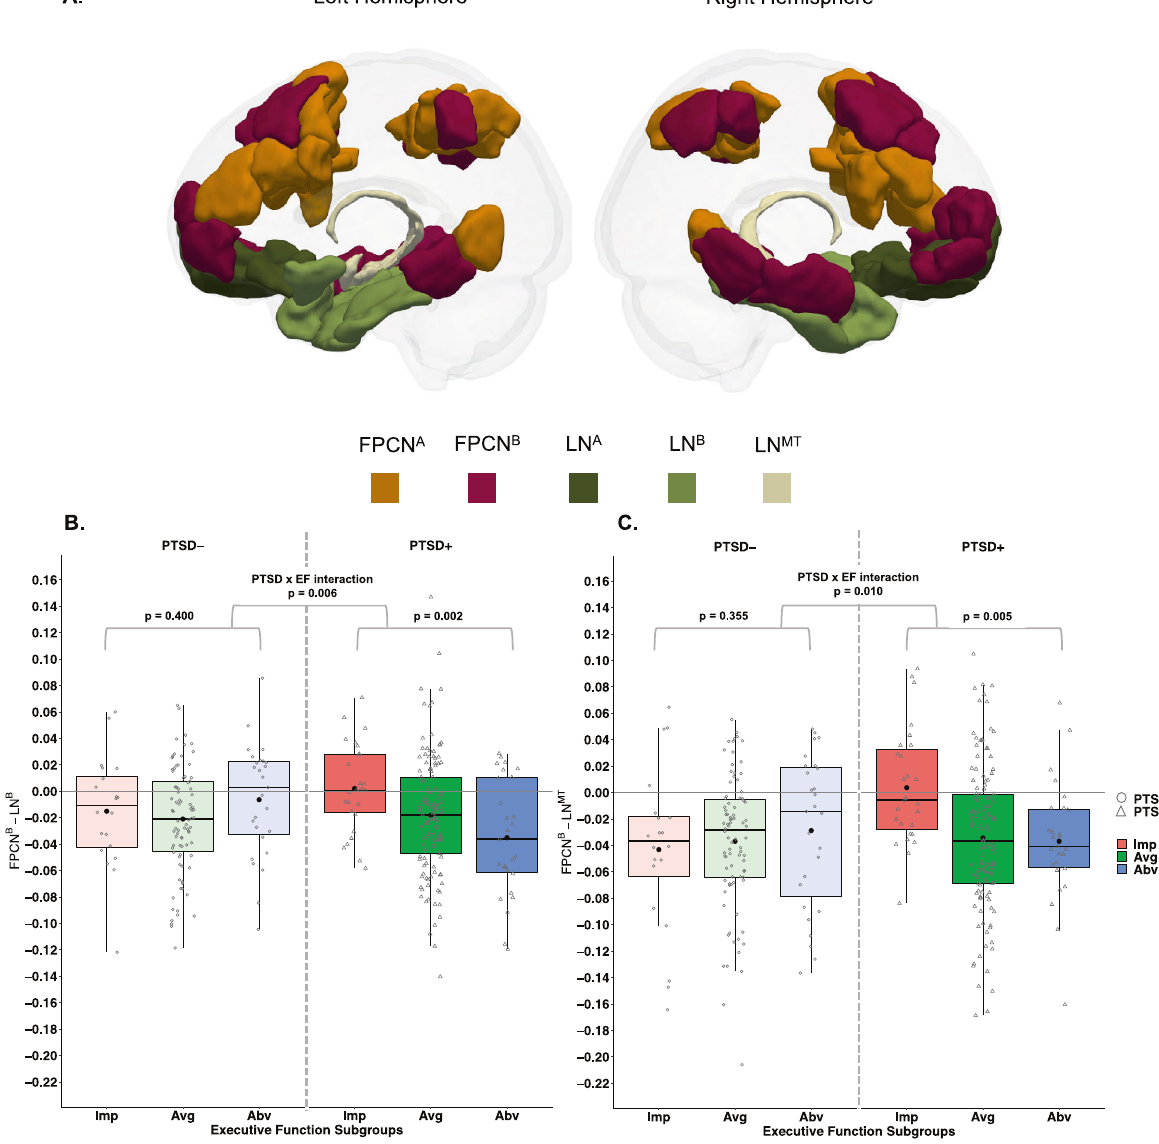
Fig. 2 Functional connectivity across executive function subgroups. A Visualization of the two FPCN subnetworks (FPCN A , FPCN B ), two LN (LN A , LN B ) subnetworks, and the third medial temporal LN (LN MT ). B PTSD and EF subgroups interacted to explain LN -FPCN connectivity, such that EF subgroups differences were present in those with PTSD. C PTSD and EF interacted to explain LN -FPCN connectivity, such that EF subgroup differences were present in those with PTSD. Within each box, the large dot denotes the mean, and the horizontal line denotes the median. The box indicates the interquartile range (the 25th to the 75th percentile) and vertical line from each box indicates the largest and the smallest value that fall within 1.5 times the interquartile range. EF executive function, PTSD posttraumatic stress disorder, PTSD − individuals without a PTSD diagnosis, PTSD + individuals with a PTSD diagnosis, Imp impaired EF, Avg average EF, Abv above-average EF, LN limbic network, FPCN frontal parietal control